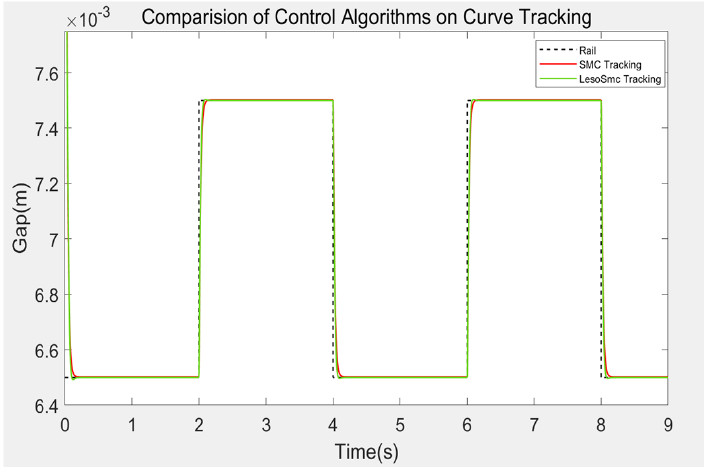
Figure 14. Comparison of curve tracking un-der SMC and LESOSMC algorithms